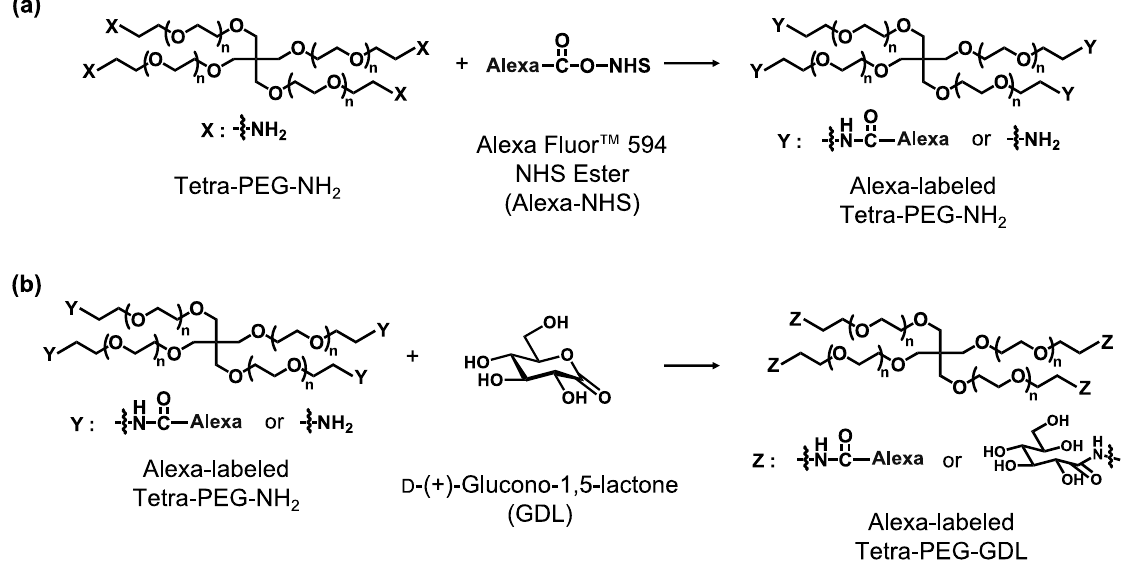
Figure 7. Reaction Scheme of Tetra-PEG-NH 2 and Gluconolactone ( a , b